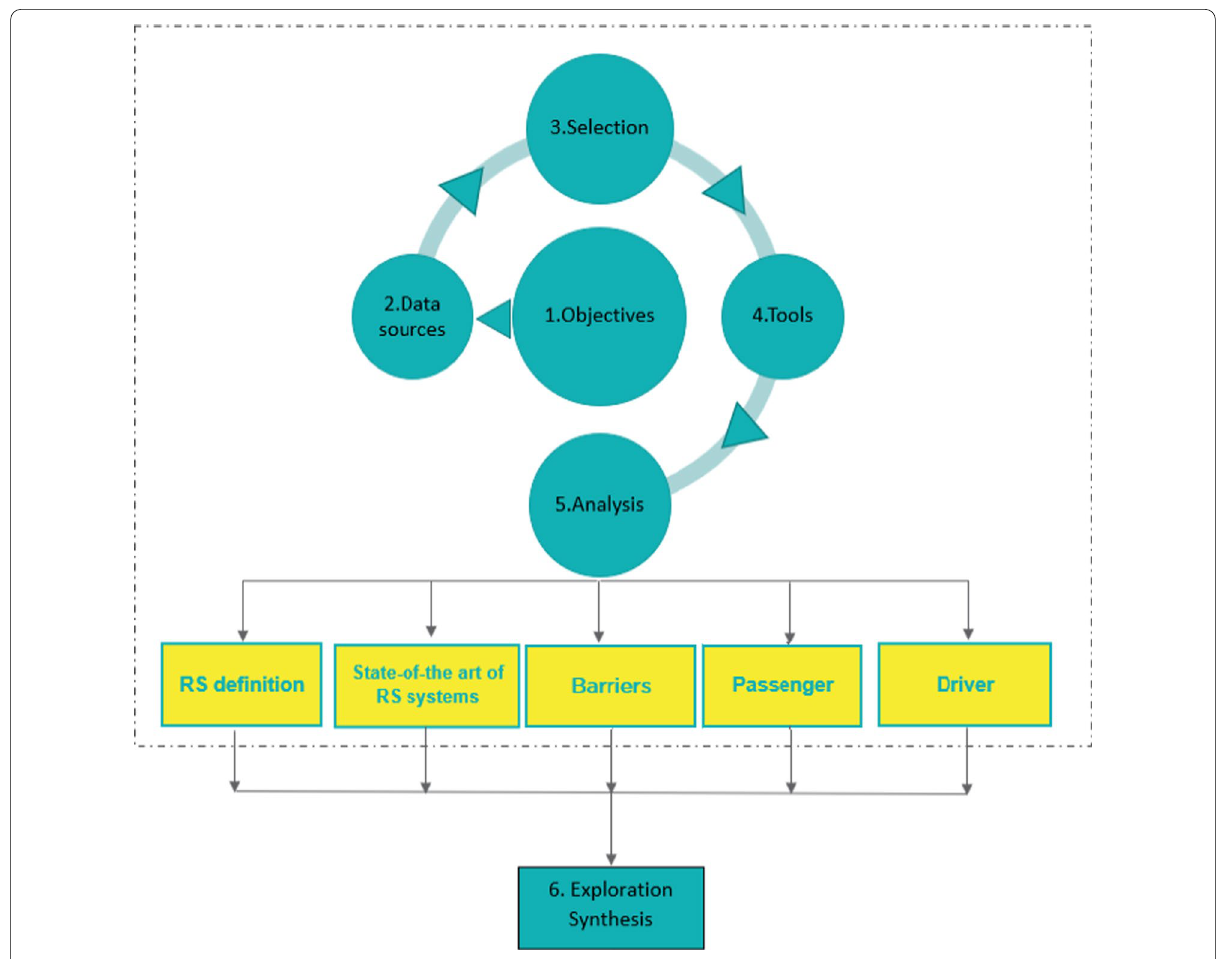
Fig. 1 Methodological